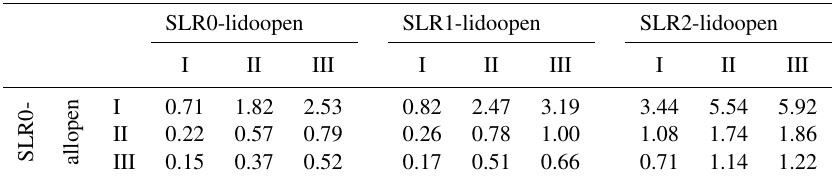
Table 11. Ratio of future flood damage and SLR0-allopen under varying IPSs (developments in the future). I: risk-averse IPS; II: medium IPS; III: risk-taking